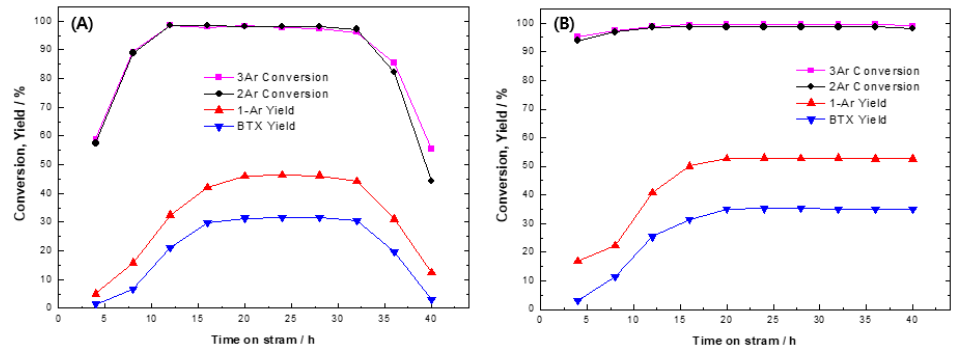
Figure 5. Hydrocracking (HCK) performances for 1-methylnaphthalene and phenanthrene over Ni 2 P/ β ( A ) and Ni 2 P/DS- β ( B ) at 653 K and 6.0 MPa.